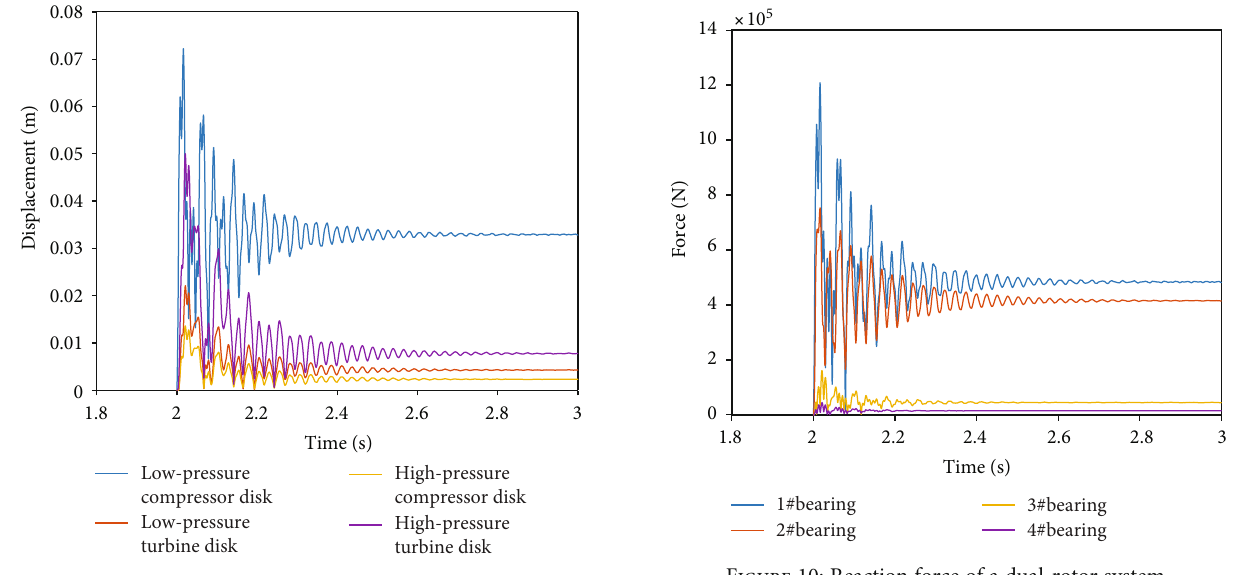
Figure 9: Displacement response of a dual-rotor system. Table 3: Displacement response of a dual-rotor system.